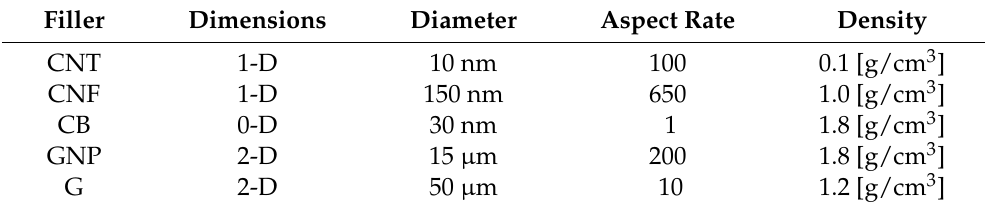
Table 1. The physical characteristics of carbon-based